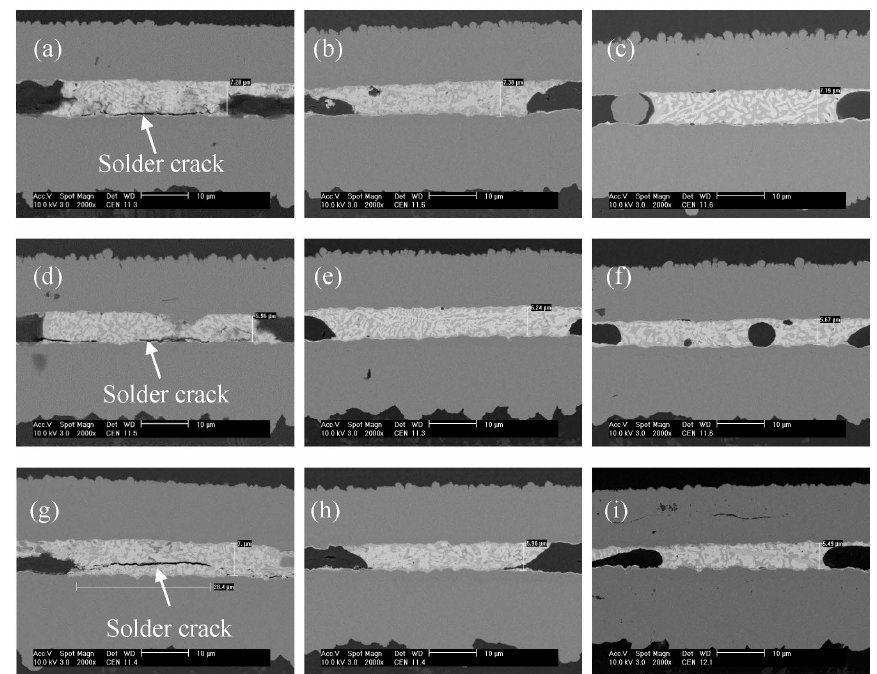
Figure 19. SEM images of SnBi58 solder ACFs joints by 200 °C 10 s TC bonding as a function of resin types and bonding pressures. ( a , d , g ) Acrylic base resins with 1, 2, and 3 MPa bonding pressures; ( b , e , h ) Imidazole epoxy with 1, 2, and 3 MPa bonding pressures; ( c , f , i ) Cationic epoxy with 1, 2, and 3 MPa bonding